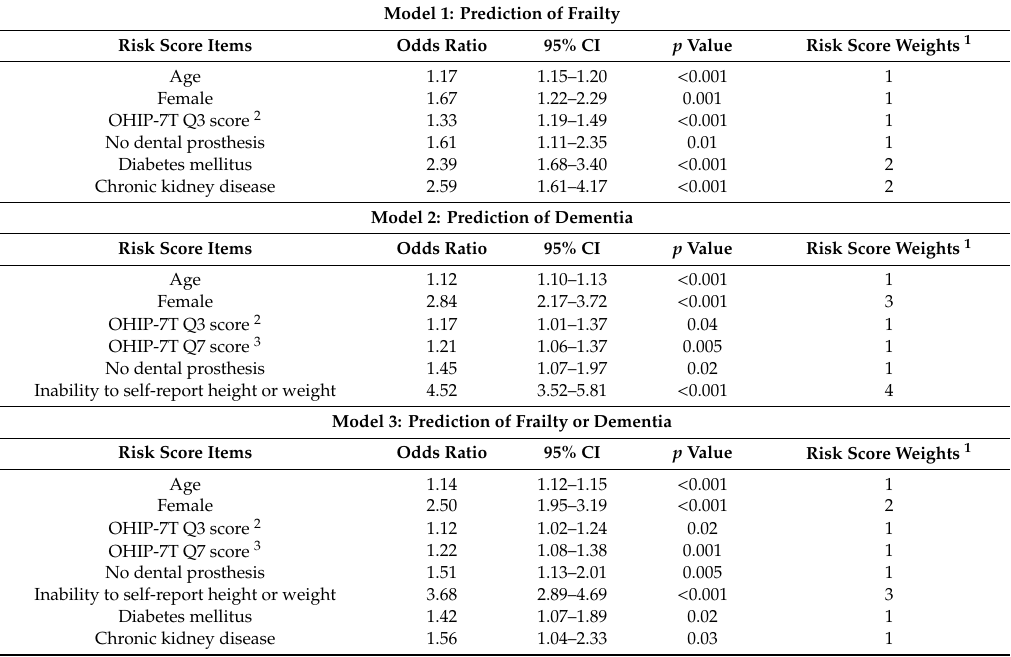
Table 3. Prediction of frailty or dementia by the Oral Health for Frailty / Dementia (OHFD) Model. Model 1: Prediction of